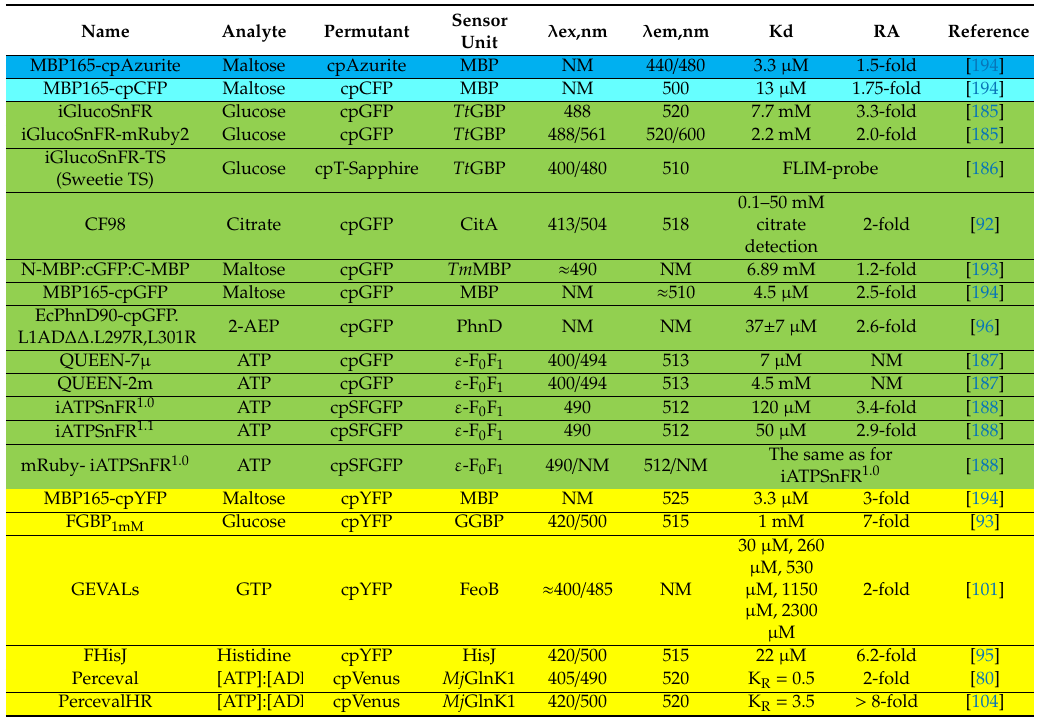
Table 5. GEFIs for organic metabolites measuring.